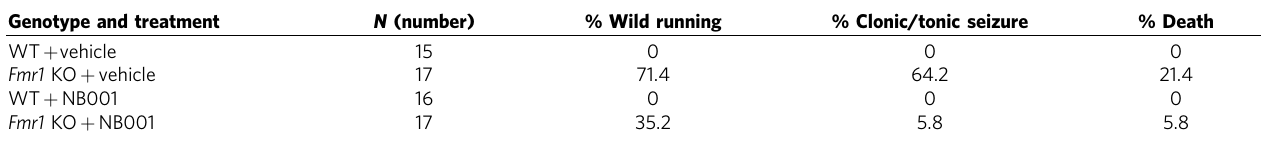
Table 2 | Acute administration of NB001 attenuates audiogenic seizures. Genotype and